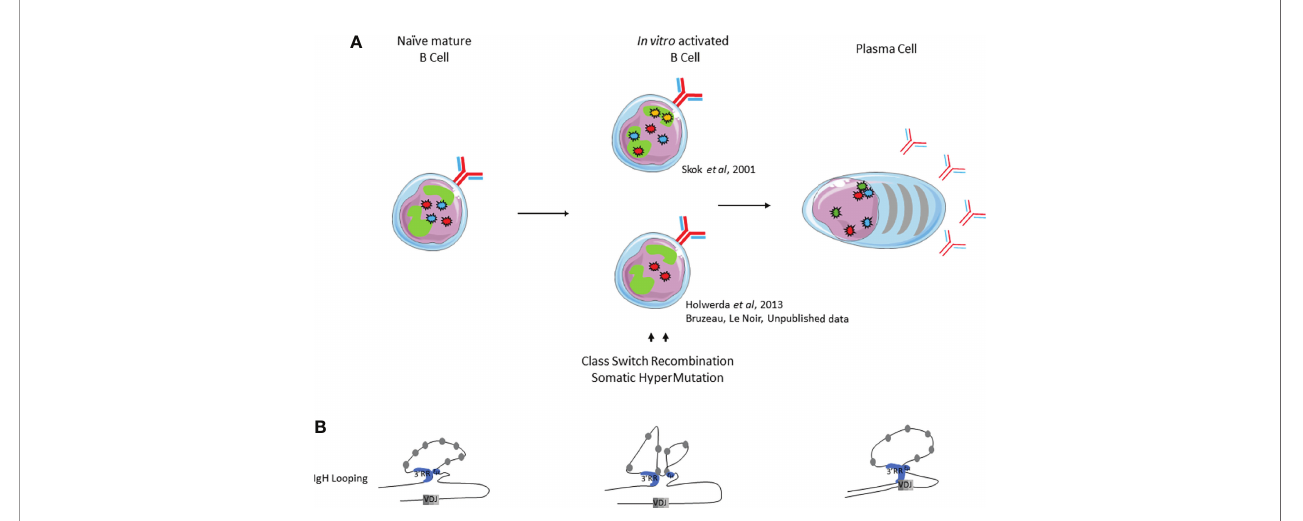
FIGURE 4 | Immunoglobulin loci positioning and conformation within the nucleus during late B cell development. (A) . Nuclear positioning of IgH, Igk and IgJ chains. (B) . IgH looping. IgH alleles are represented by red stars, Ig k alleles by blue stars , Ig l alleles by yellow stars and J chain alleles by green